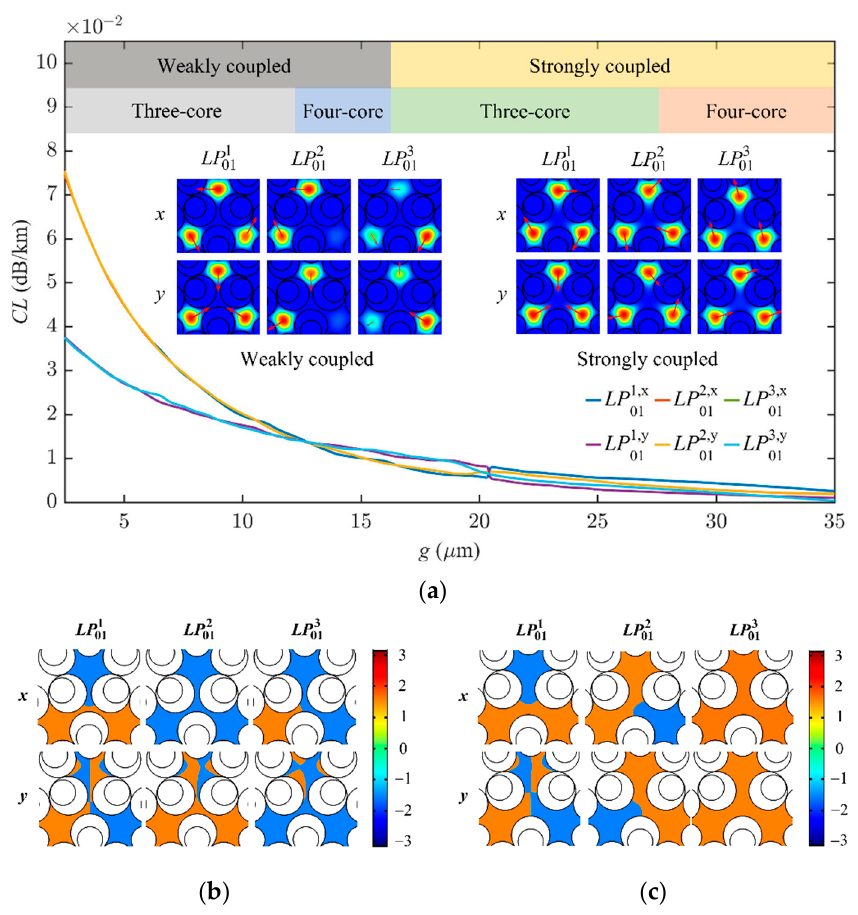
Figure 3. ( a ) Influence of various g on CL and the coupling characteristics, the direction of the red arrows represents the direction of the electric field; ( b ) Fundamental supermode (LP 1,x , LP 1,y , LP 2,x , LP 2,y , LP 3,x , and LP 3,y ) phase distribution of the weakly coupled fiber and its color legend; ( c ) Fundamental supermode (LP 1,x , LP 1,y , LP 2,x , LP 2,y , LP 3,x , and LP 3,y ) phase distribution of the strongly coupled fiber and its color